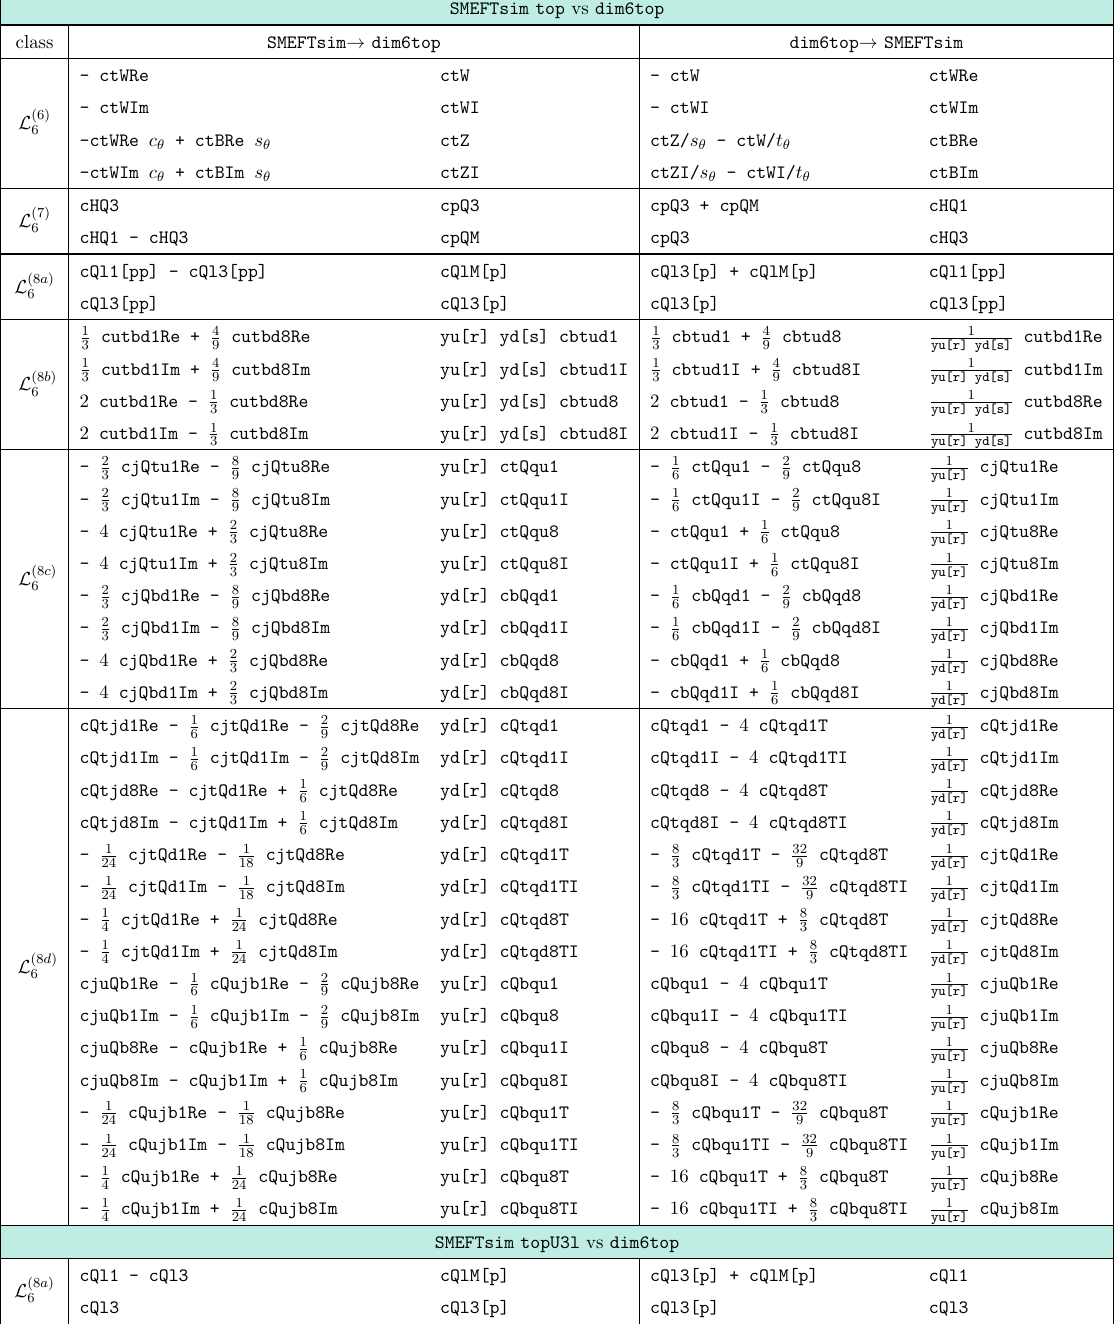
Table 25 . Upper panel: conversion table between the SMEFT parameters defined in the top version of SMEFTsim and in dim6top : parameters that require a basis rotation. Lower panel: conversion table between the topU3l version of SMEFTsim and dim6top . Only leptonic coefficients are reported here, as the other parameters behave identically to the top case. Lepton flavor indices take values p = { 1,2,3 } . In the notation yd[r], yu[r] etc, the flavor index is that of the associated righthanded light field ( d for yd and u for yu